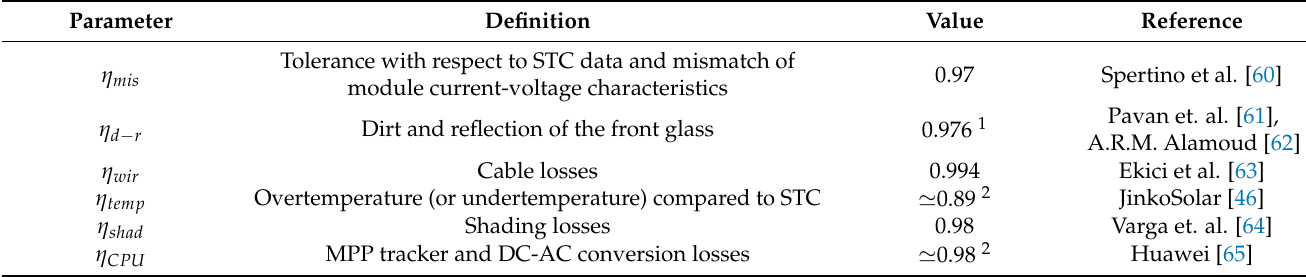
Table 14. Performance Ratio